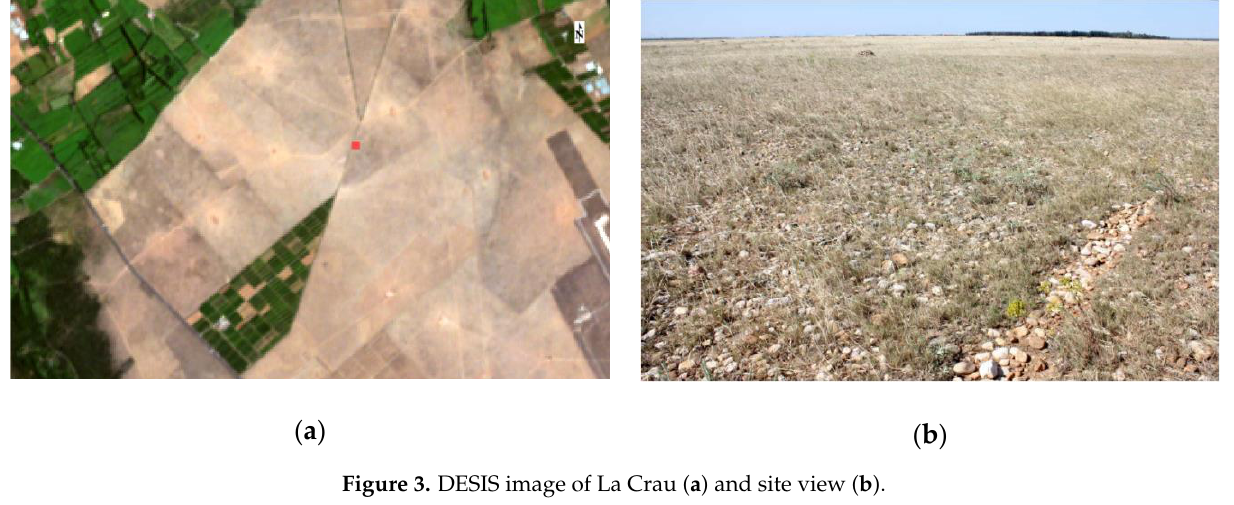
Figure 3. DESIS image of La Crau ( a ) and site view ( b ).